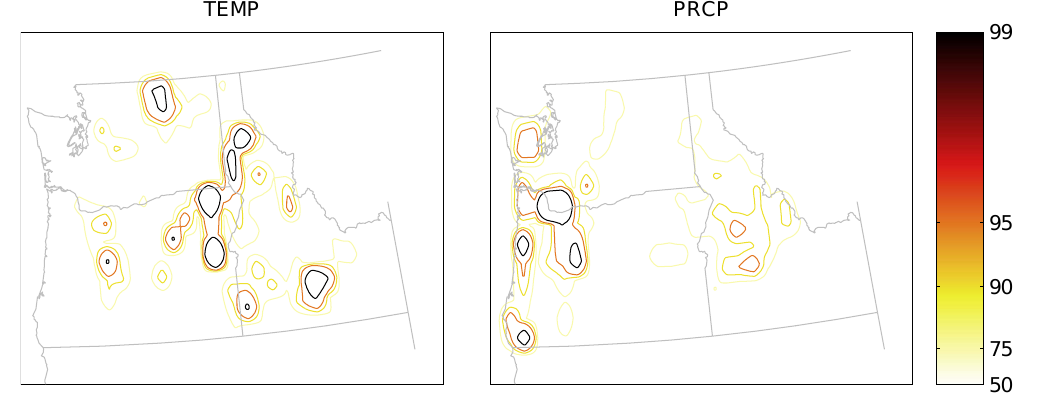
Fig. 2. Results for annual temperature and precipitation, obtained using the optimal network design calculation. Calculations were performed using regionally averaged temperature and precipitation as the target metric (defined as the average over the US states of Idaho, Oregon, and Washington). Contours show the percentile value of the grid cell weighting – higher weights denote areas where measurements contribute more to the variance explained. Results are obtained using the PRISM dataset (1948–2011), central estimates for the measurement error ( R 2 ), and a sample size of 30yr.